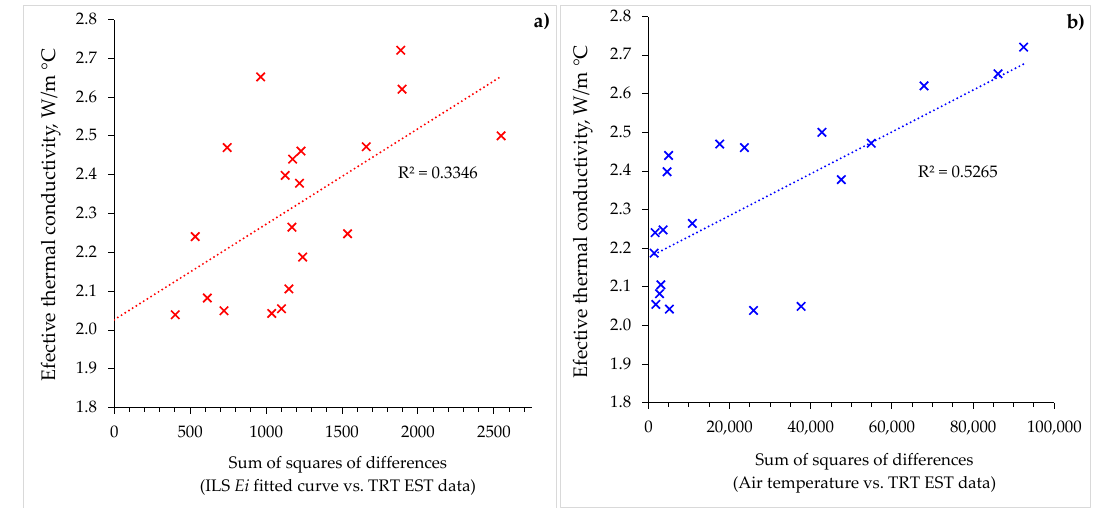
Figure 12. Results of sum of squares of differences analysis: ( a ) SUMXMY2 between ILS fitted curve and EST measured data; ( b ) SUMXMY2 between air temperature and EST measured data.